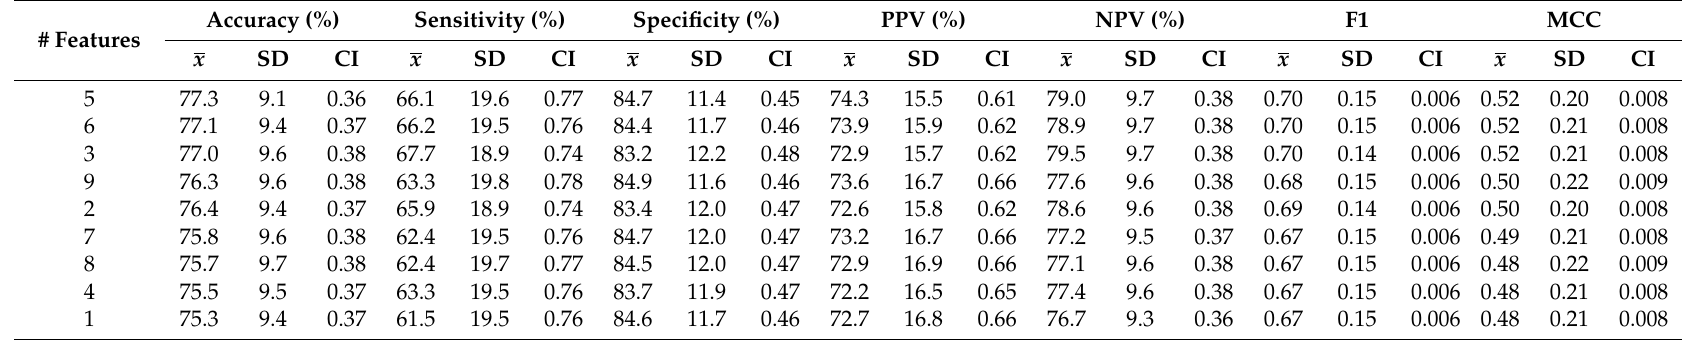
Table 6. Most frequently occurring (MFO) feature subsets for turn section results and random forest classifier using 2500-iteration random-shuffle-split cross validation (2500-RSS), ordered by ranked performance. PPV: positive predictive value, NPV: negative predictive value, MCC: Matthews correlation coefficient, x : mean, SD: standard deviation, CI: 95% confidence